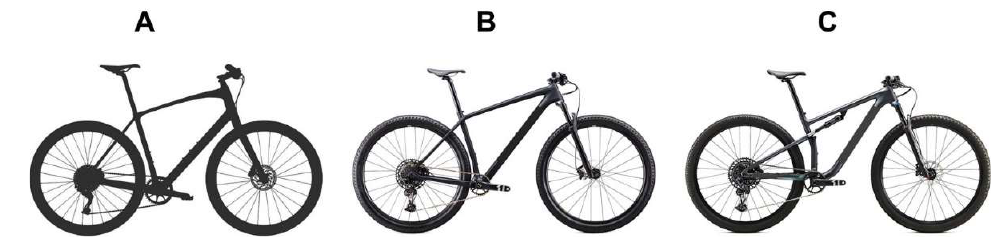
Figure 8. Rigid ( A ), hardtail ( B ) and full suspension ( C ) bike models for the XC-MTB